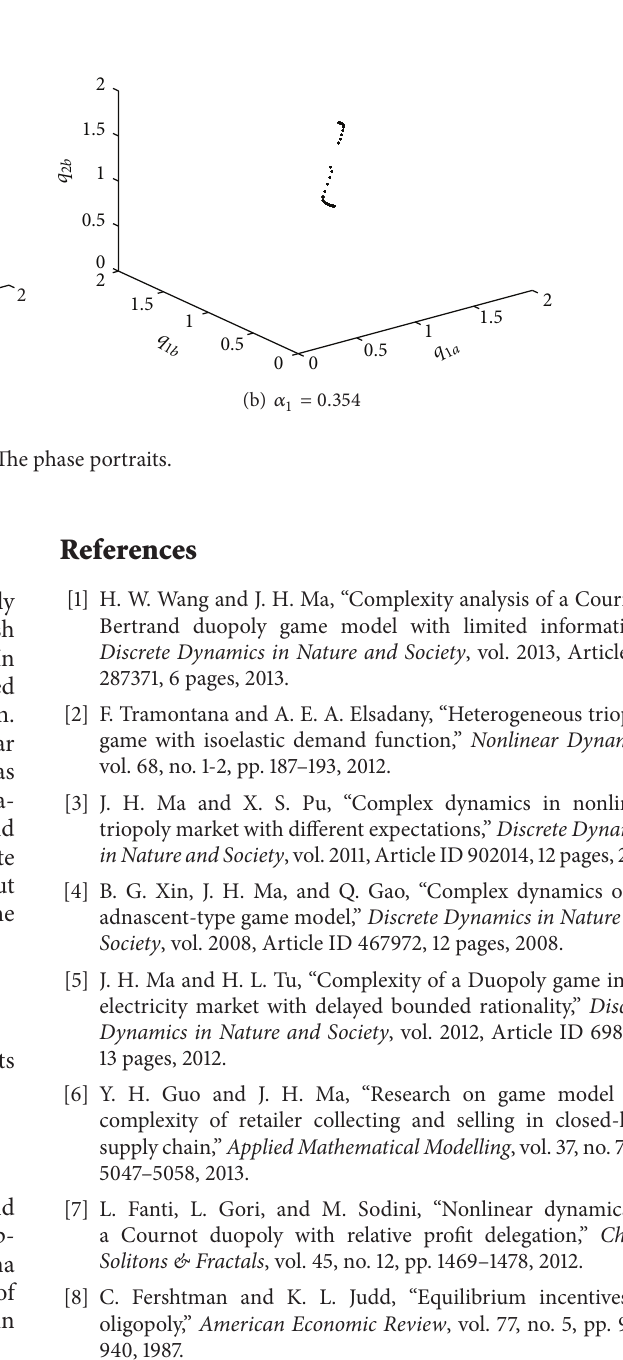
Figure 7: The time series of 𝑞 1𝑎 .